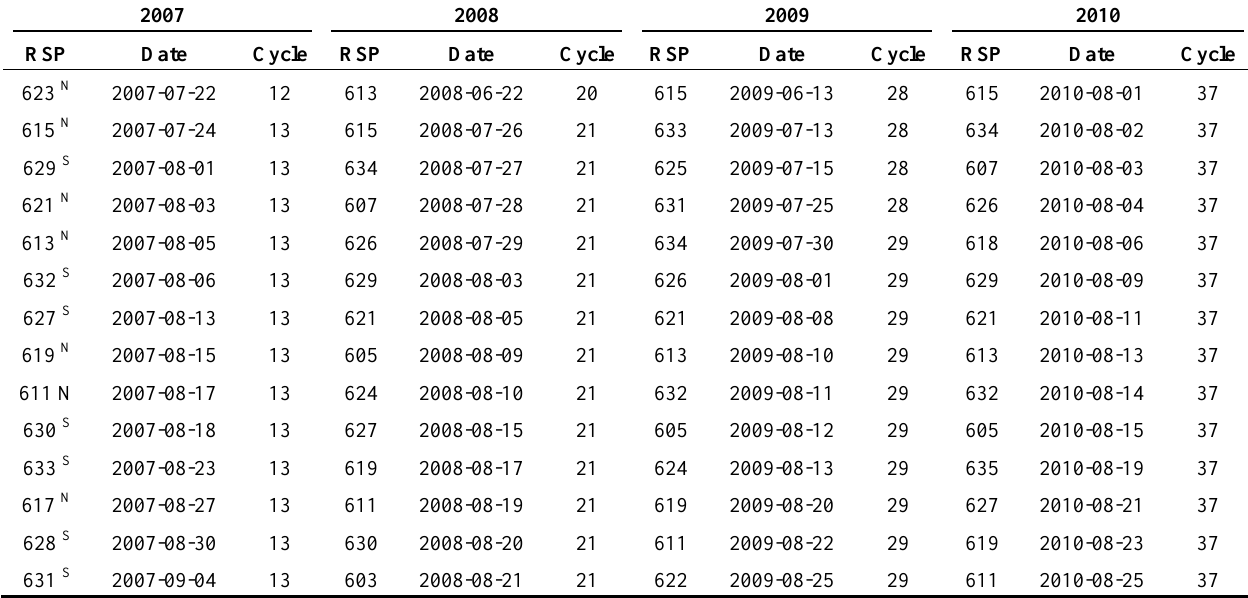
Table 1. Advanced Land Observing Satellite (ALOS) Phased Array L-band type Synthetic Aperture Radar (PALSAR) Kyoto and Carbon (K&C) strip data acquired during summer/fall of 2007, 2008, 2009 and 2010. For the 2007 dataset, N refers to data acquired over the county of Västerbotten in the north of Sweden and S refers to data acquired over the counties of Västra Götaland and Jönköping in the south of Sweden. RSP (Reference System for Planning) corresponds to the satellite path number; Date corresponds to image acquisition date; Cycle corresponds to the satellite orbital cycle number (1 cycle = 46